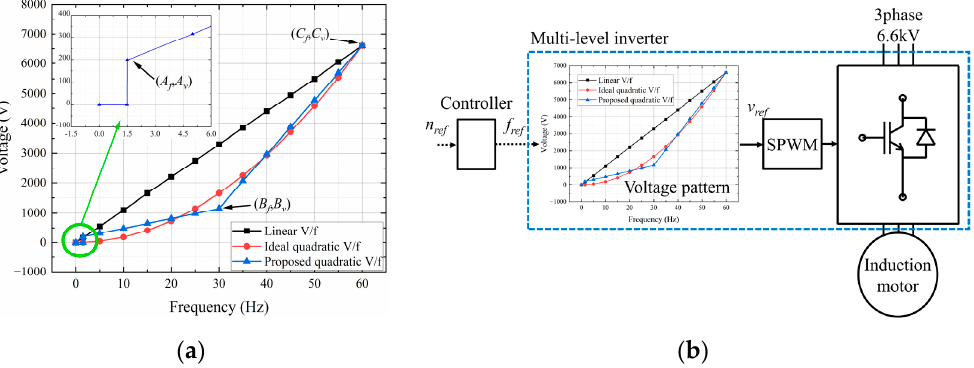
Figure 4. Operating principle according to linear V/f control and quadratic V/f control. ( a ) Voltage pattern curves; ( b ) control configuration. SPWM: sinusoidal pulse width modulation.